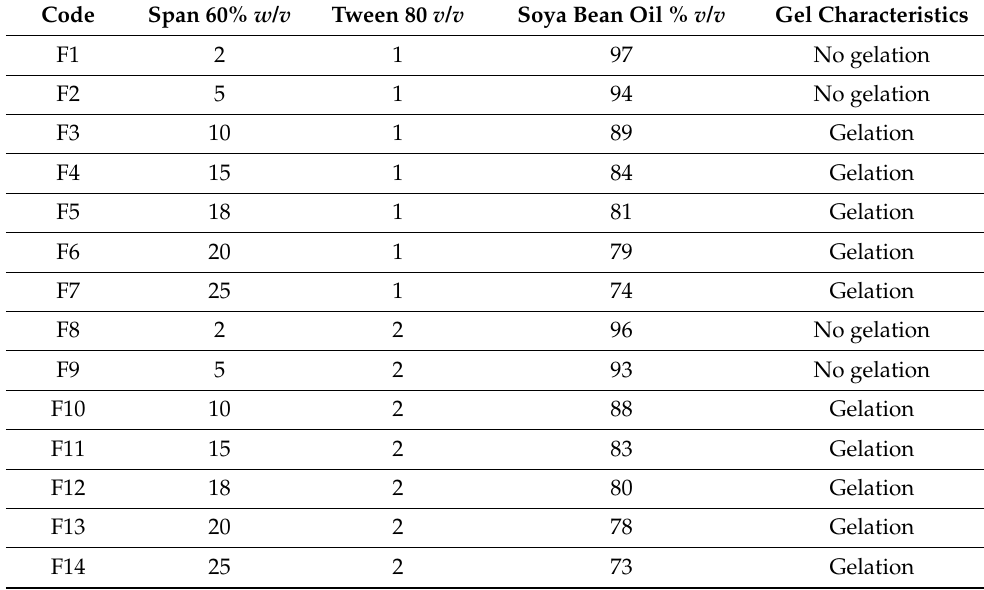
Table 5. Formulation chart for varying organogel combinations and gelation characteristics.